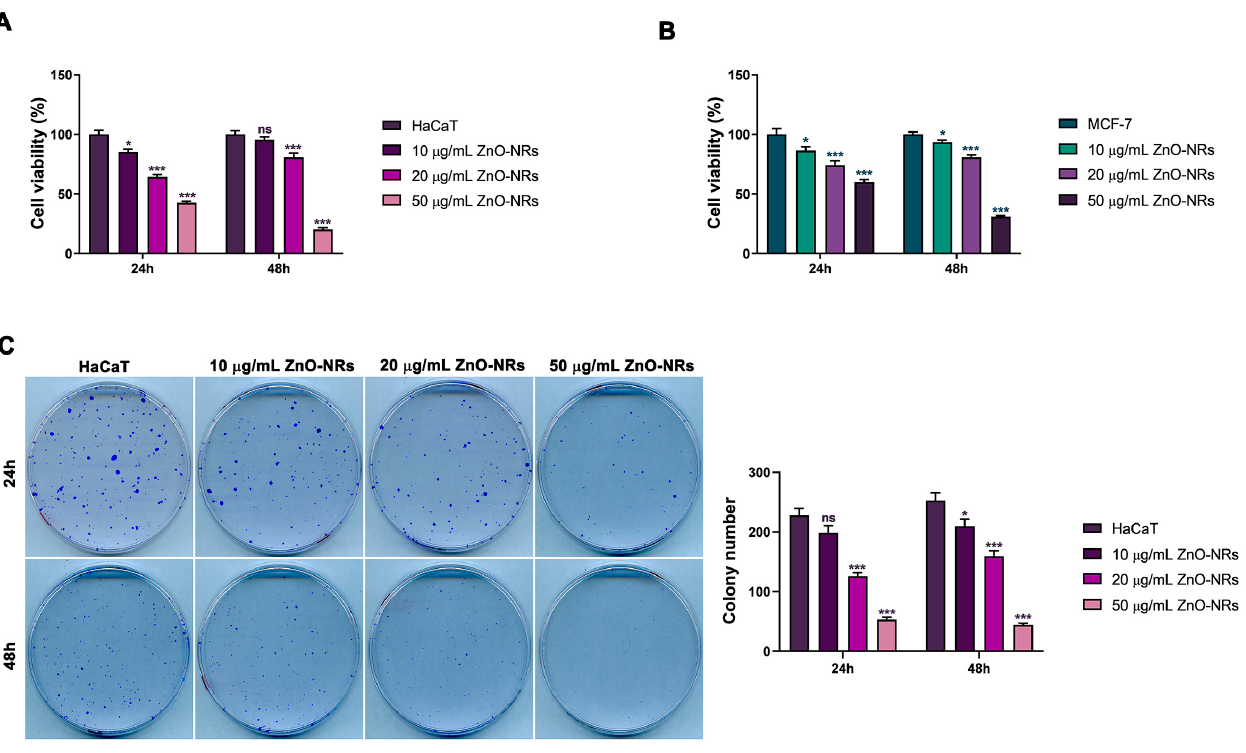
Figure 2. ZnO-NRs’ e ff ects on HaCaT and MCF-7 cells . HaCaT and MCF-7 cells were either untreated or treated with the indicated ZnO-NR concentration for 24 and 48 h. The ncrease of ZnO- NR concentration caused a decrease ( A , B ) in cell viability and ( C , D ) clonogenicity ability. ( E ) Intracellular ROS measured in both cell lines after ZnO-NR treatment using 2’, 7’-dichloro fl uorescin diacetate (DCFH-DA). ( F ) Intracellular Zn 2+ measured after ZnO-NR treatment using Zinquin. Experiments were repeated three times. * p < 0.05, ** p < 0.01, and *** p < 0.001. ns, not signi fi cant.